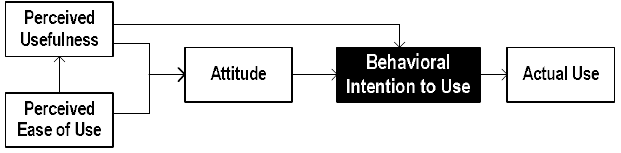
Figure 1. Technology Acceptance Model (Source: Sepasgozar et al. [19] adopted Davis [21]).